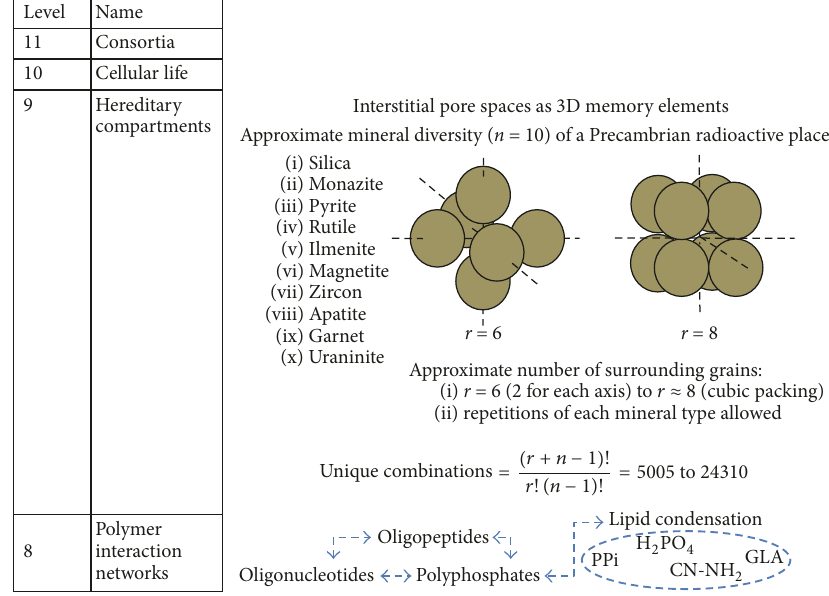
Figure 9: Inferred polymer production pathways at object level 8 enabled by chemical reactions from object levels 1–7 and mineral diversity combination estimates for compartments composed of placer sediment mineral grains at object level